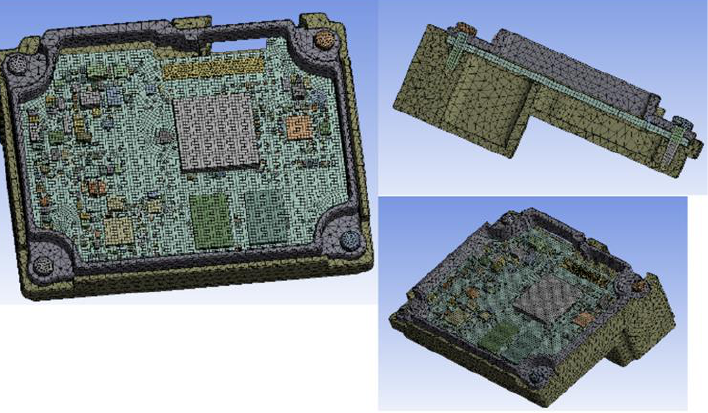
Figure 9. FEA mesh. The principal strain on PCB was obtained after numerical analysis. The results for the four considered temperatures are shown in Figure 10.